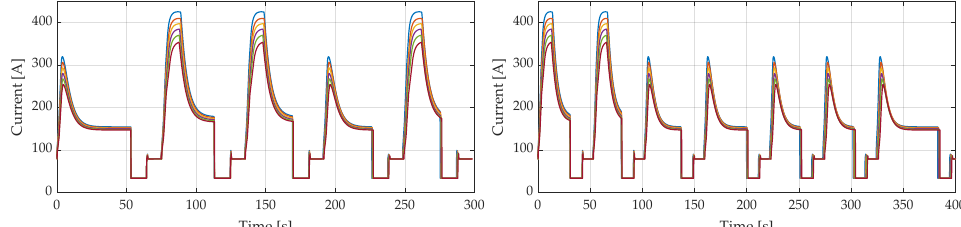
Figure 19. Current of IMC trolleybuses according to the vehicle’s weight covering the outgoing ( left ) and return ( right ) journeys of line 15. The weights start at 30 t (upper blue line) and decrease to 20 t (bottom red line) with 2 t